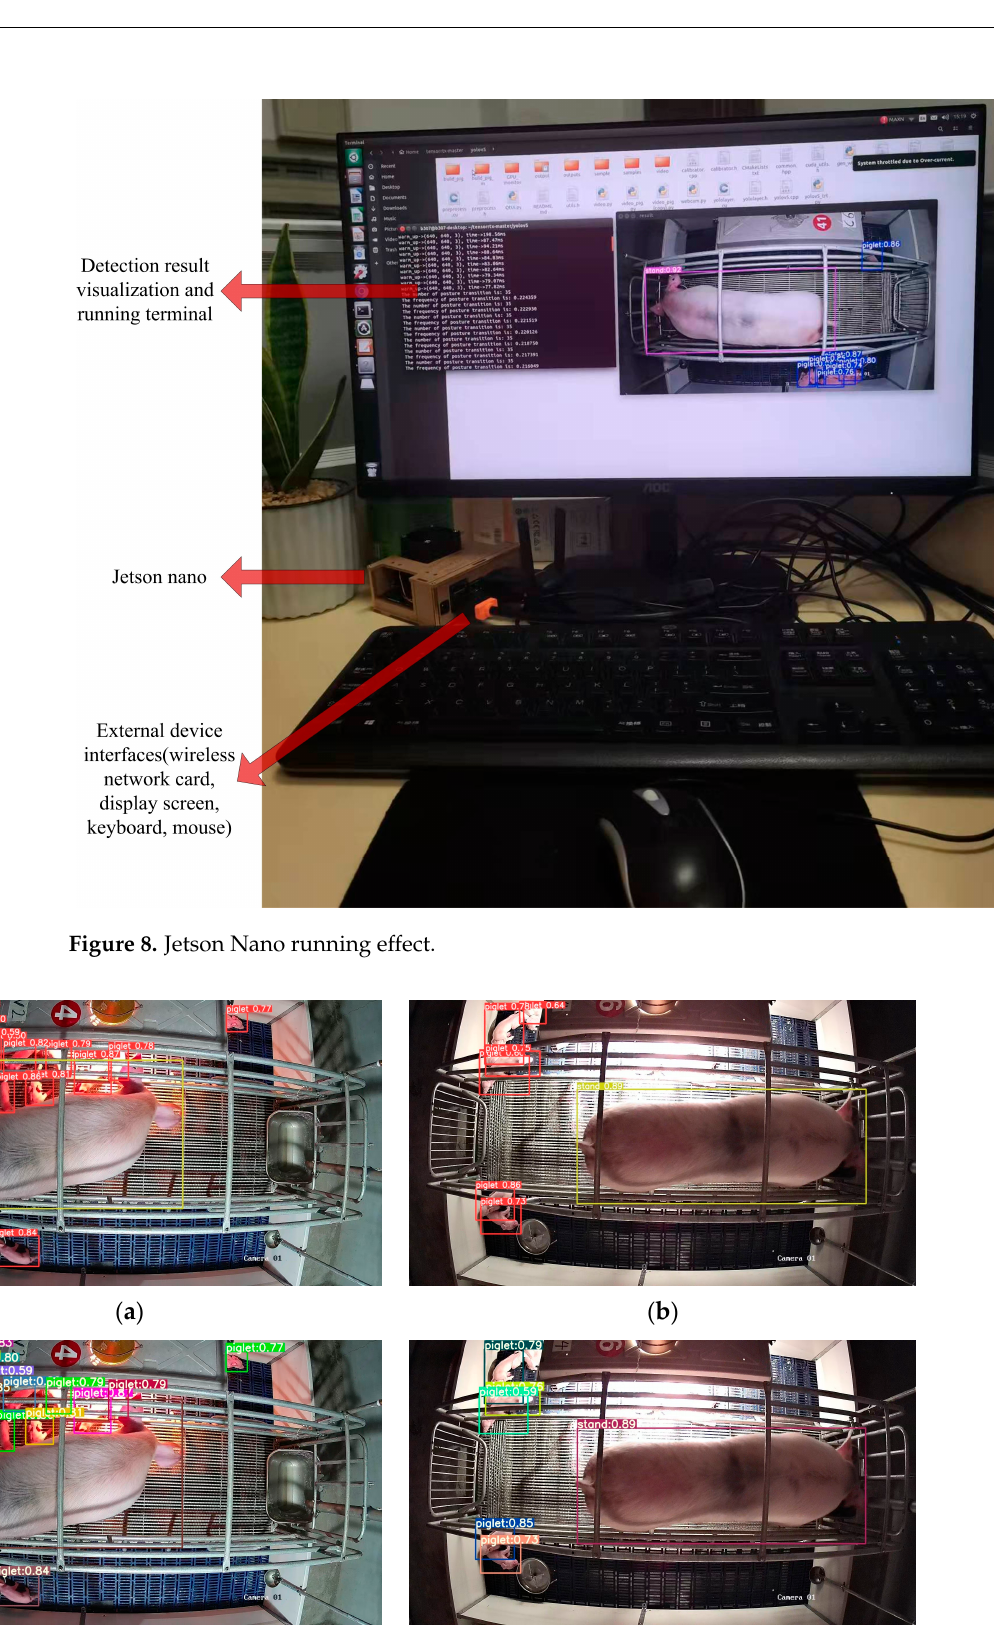
( b ) Figure 10. GPU utilization during the detection of images and video. ( a ) Image detection, ( b ) Video detection. 3.3. Implementation of Sow Farrowing Early Warning and Supervision According to the posture sequences of the sows at different moments output by the model, the sow posture transition frequency from 48 h before farrowing to 24 h after far- rowing was calculated as follows: n f T = (5) where f represents the sow posture transition frequency, n represents the number of pos- ture transitions, and T represents time (unit h). The values were continuously updated during the detection process. As shown in Figure 11, three sows were selected as examples to visually analyze the posture transition frequency, which changed in a consistent direction across sows. The data of 22 sows from the experimental sample were tested and analyzed, and the range of change in the average posture change rate of sows from 48 h before farrowing to 24 h after farrowing is shown in Figure 12a, and the average posture change frequency of sows